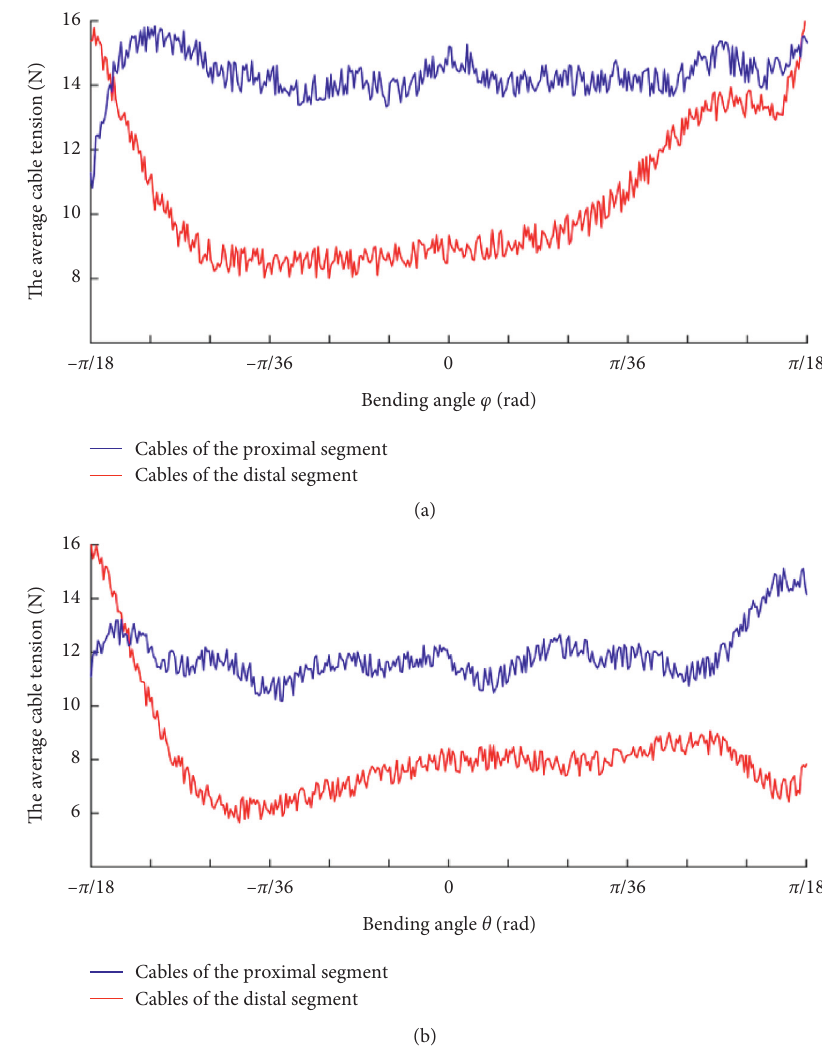
Figure 15: Cable tension during the bending motion of the proximal segment. (a) Bending angle φ (rad). (b) Bending angle θ